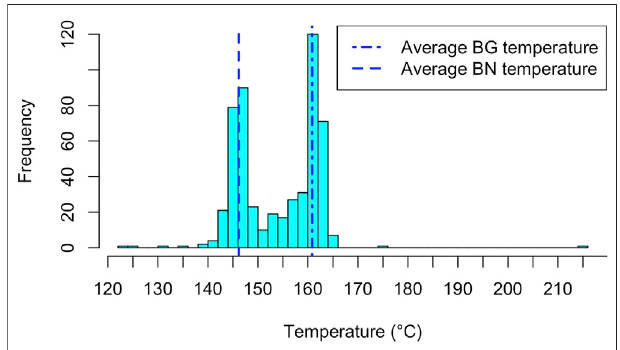
FIGURE 3 | Histogram of temperature data collected in Solfatara since 1889. Dashed-dotted line and dashed line refer to the average temperature value measured since 1980 at the fumarolic vents of Bocca Grande (BG) and BoccaNuova(BN),respectively(Caliroetal.,2014).Dataandreferences for older measurements, described by Sicardi and published in Italian jounals, are provided as Supplementary Materials